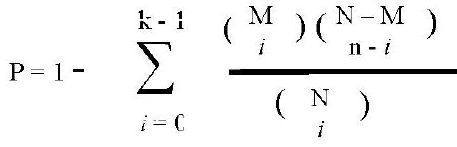
Table 1—differentially activated: 497, differentially organized: 683). This operation was performed with Matlab using the ―hygepdf‖